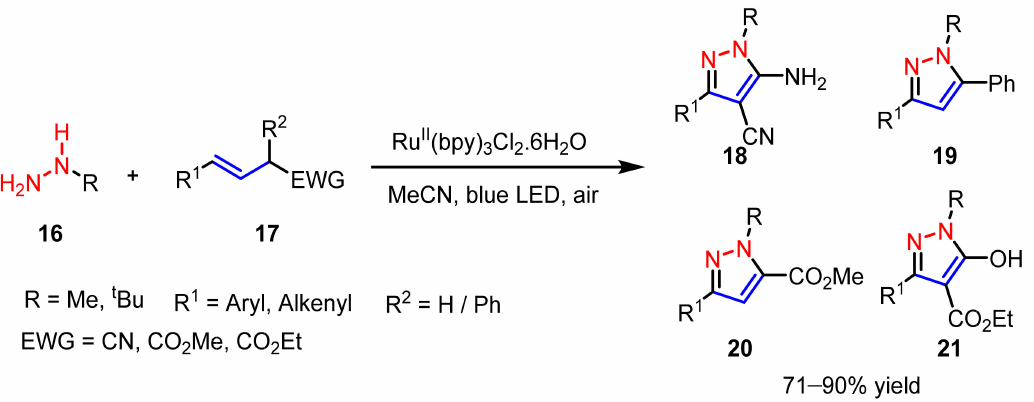
Scheme 9. Ru II -catalyzed photoredox cyclization for pyrazole